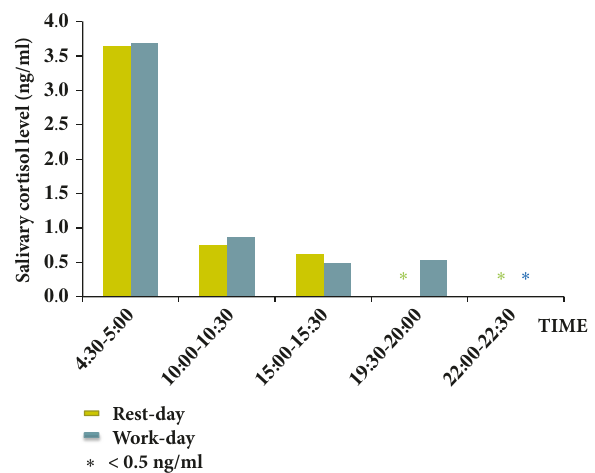
Figure 5: Level of cortisol in saliva samples collected from a healthy volunteer at different intervals on two different